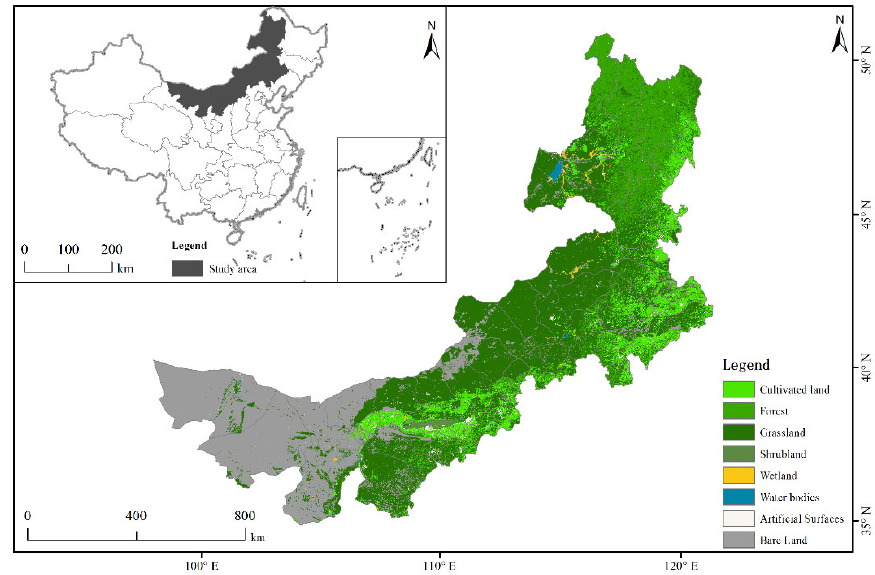
Figure 1. Location and use distribution map of the study area.